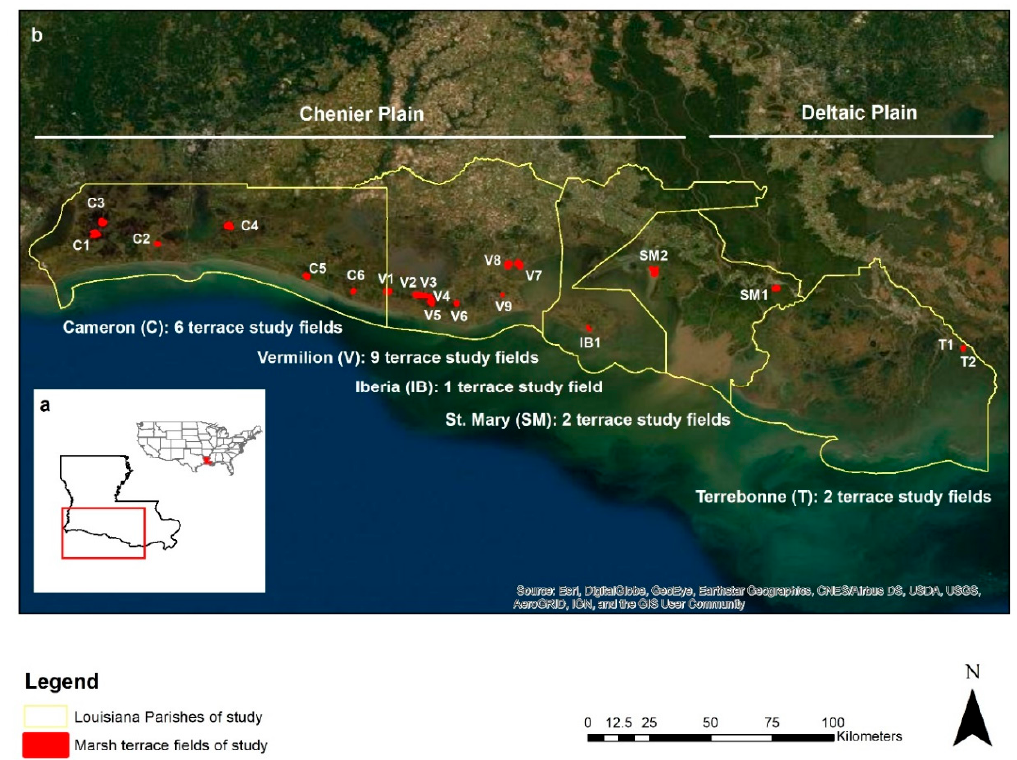
Figure 1. ( a ) Coastal Louisiana. U.S.; ( b ) Marsh terrace fields of study selected to assess performance over time in the Chenier Plain and Deltaic Plain Region in Coastal Louisiana.